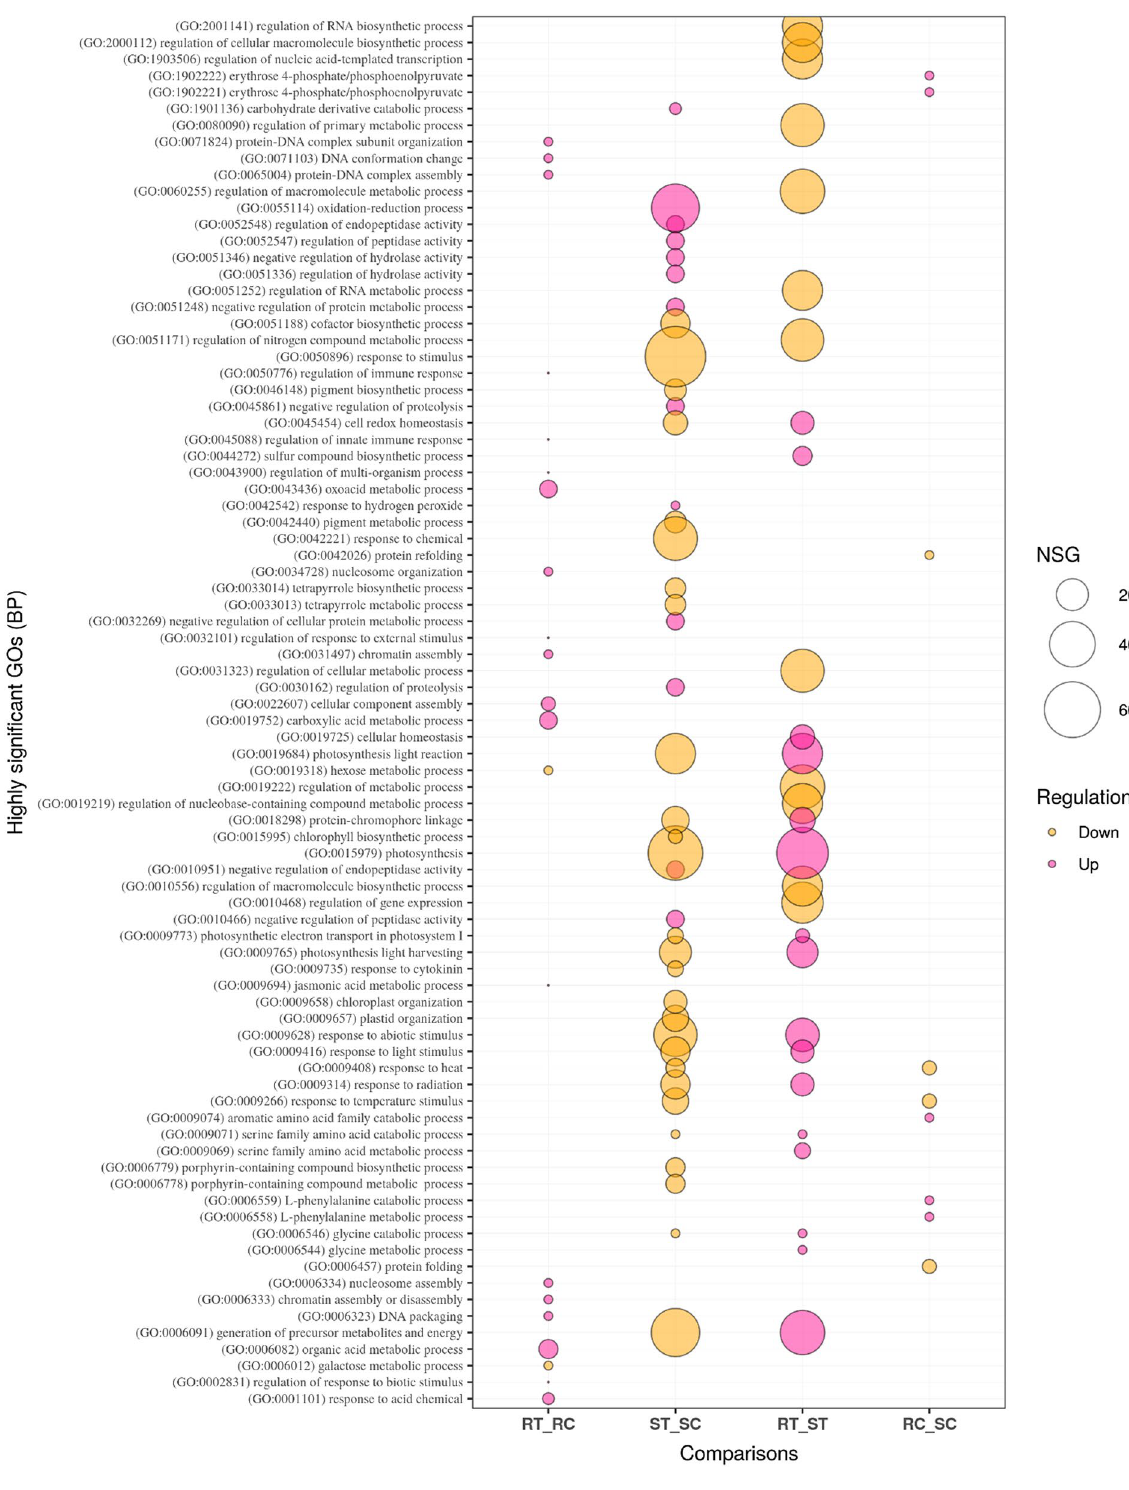
Figure 7. Bubble plot of the GO enrichment terms related to biological process (BP). The size of the circles shows the number of significant genes (NSG) associated with each GO term. Purple and orange colors show up-regulated and down-regulated DEGs, respectively. RC (resistant control), RT (resistant treatment), SC (susceptible control), and ST (susceptible treatment). The plot was created using ‘ggplot2 version 3.3.5’ R/CRAN package (https:// ggplo t2. tidyv erse.